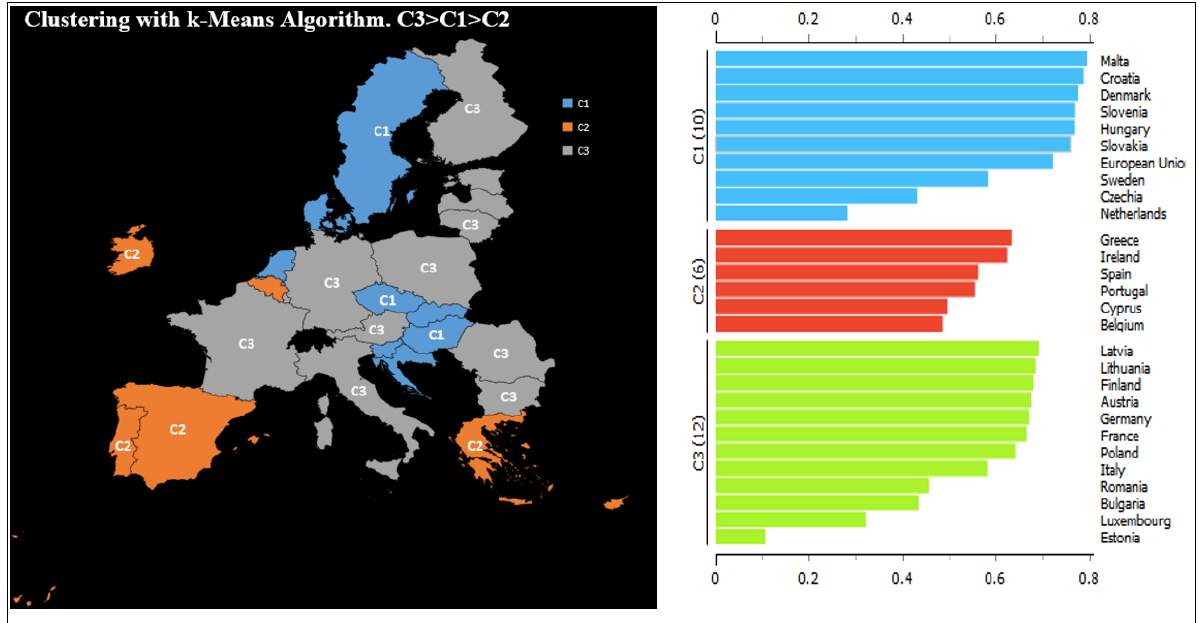
Figure 3. Broadband price index in